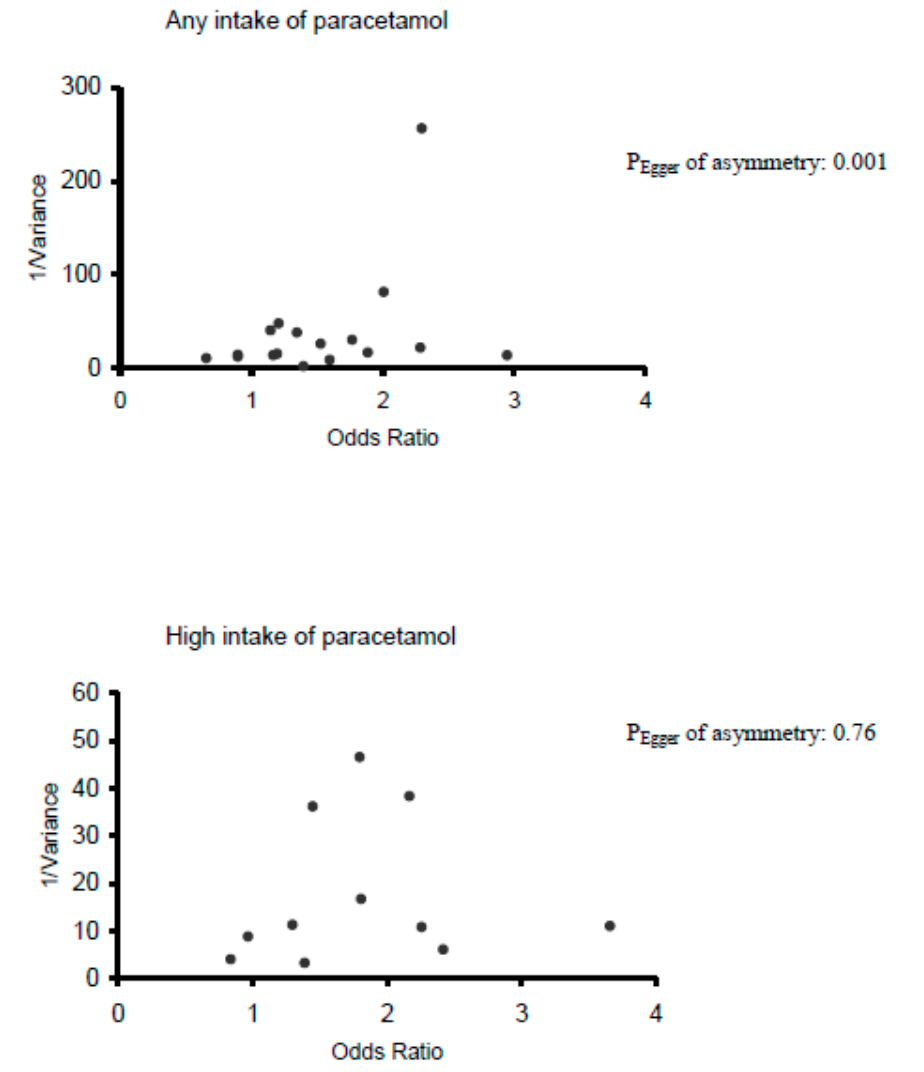
Figure 3. Funnel plots of Odds Ratio versus inverse variance of Odds Ratio.